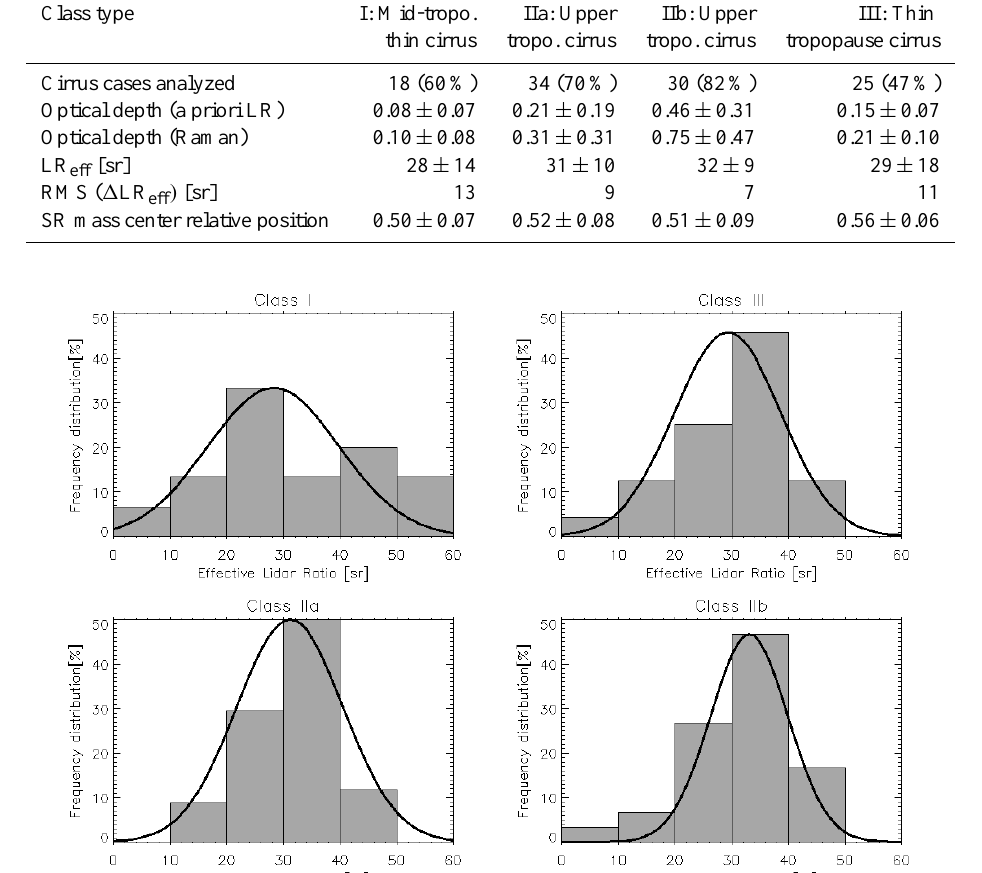
Fig. 4. Frequency distribution functions of LR eff computed for the four cirrus classes fitted with Gaussian functions (black curves), which are determined by the mean of LR eff and the root mean square of Δ LR eff .